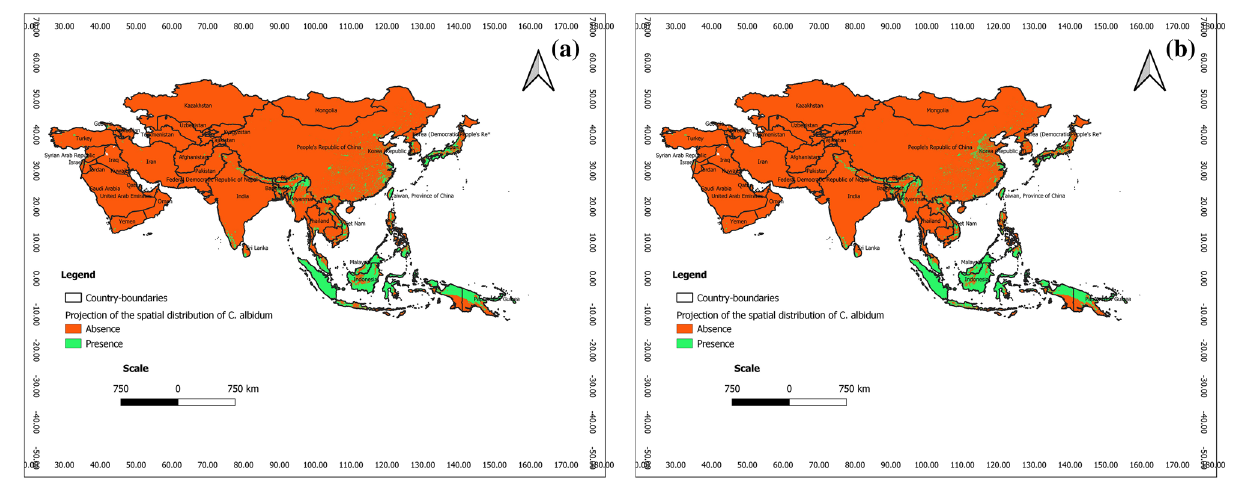
Figure 11. Projections of the spatial distribution of C . albidum according to RF across Tropical Asia: a) at present; b) at horizon 2060 SSP585 (the maps were generated using R version 4.1.3 (https:// www.R- proje ct. org/), QGIS 3.18.1 (http:// qgis. osgeo. org), and WGS 84 as Coordinate Reference